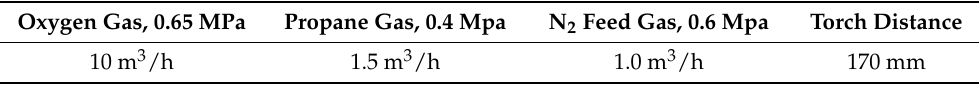
Table 1. HVOF parameters.